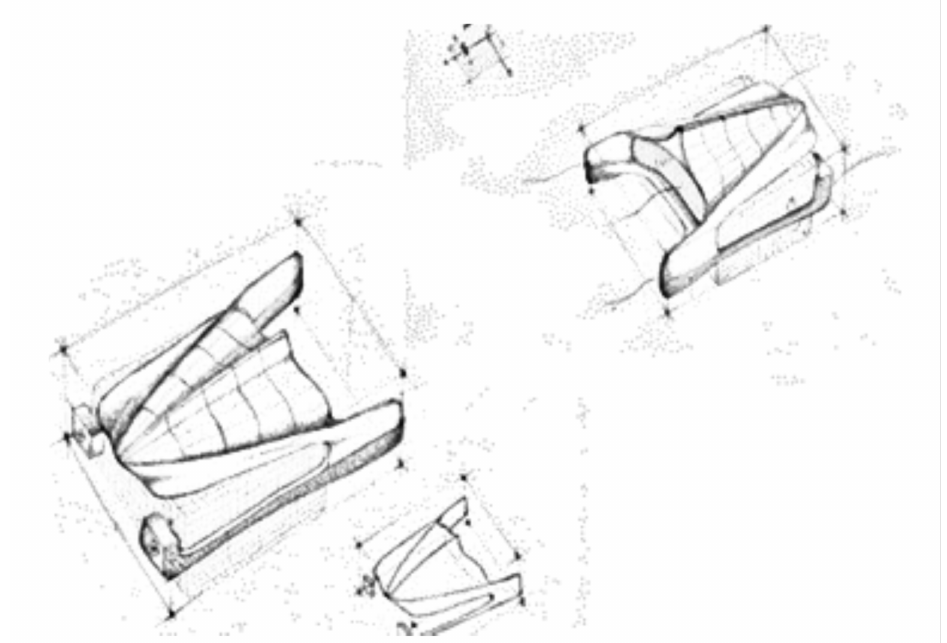
Figure 11. Futuristic Style Sketch.